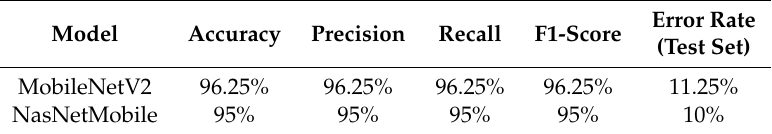
Table 9. Comparison between MobileNetV2 and NasNetMobile on both